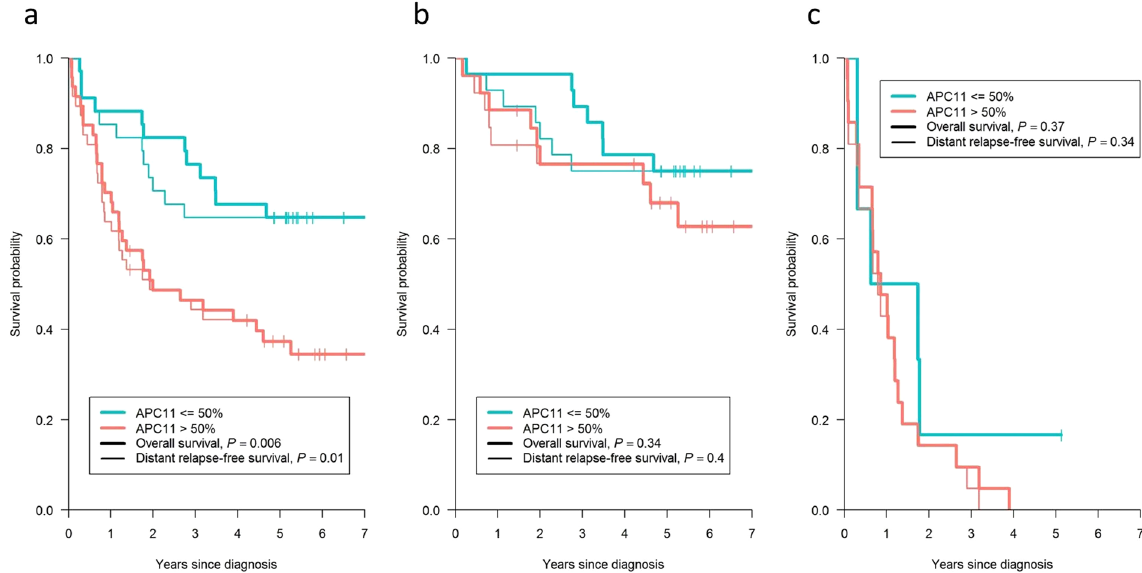
Figure 5. Kaplan-Meier curves presenting the probability of CRC patient survival according to APC11 protein expression. ( a ) All patients (n = 81). ( b ) Patients with M0 disease (n = 54). ( c ) Patients with M1 disease (n = 27). P values displayed were calculated by the log-rank test. M1: patients with metastasis at CRC diagnosis; M0: patients without metastasis at CRC diagnosis.